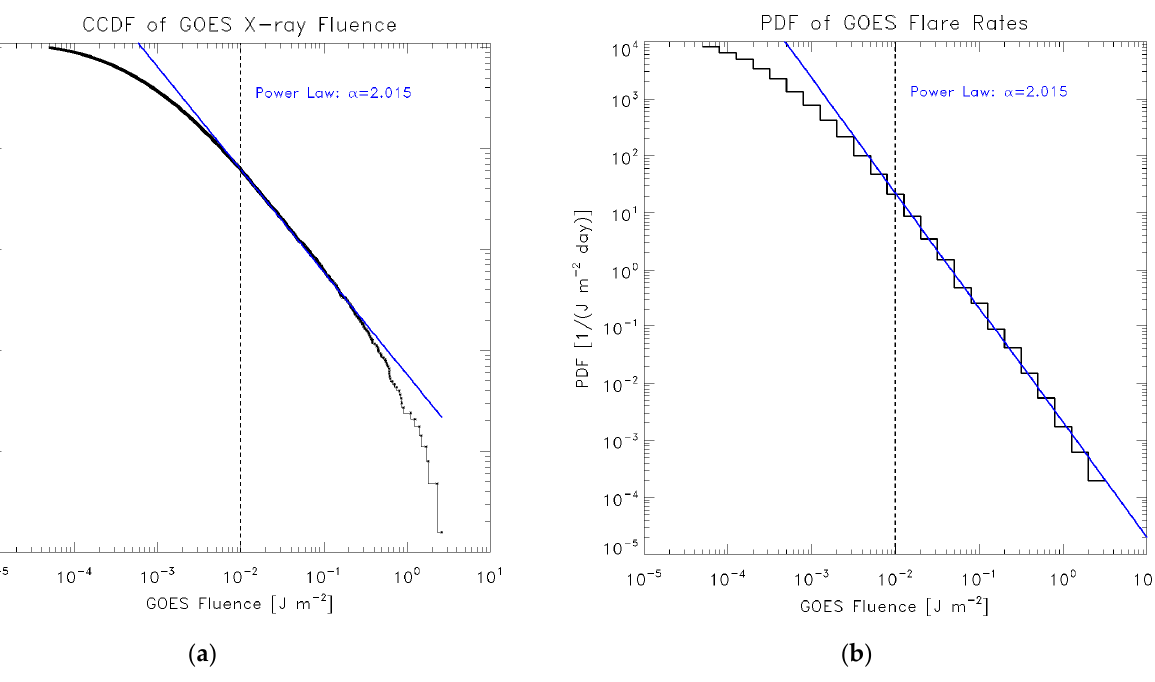
Figure 3. ( a ) The blue line shows the power-law fit to the observed CCDF of GOES flare fluence data. ( b ) The derived power-law distribution overplotted on the observed flare occurrence rate histogram. The vertical dashed line indicates the lower boundary (1 × 10 − 2 J m − 2 ) of data used for fitting.